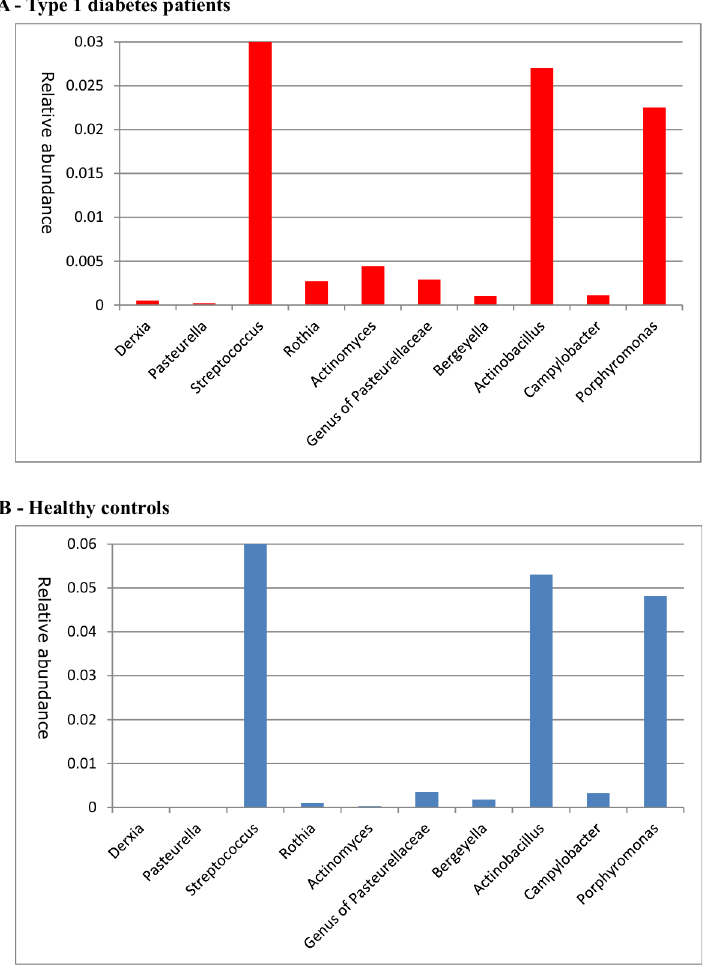
Fig 4. Most discriminating oral species. Relative abundancesof most discriminating oral microbiota resulting from our elastic net analysisfor (A) T1D patients and (B) healthy controls (B). Please note that the y- axes differ betweenfigures and that Streptococcus abundancewas relatively very large (0.53 in T1D and 0.43 in healthycontrols) and did not fit in the